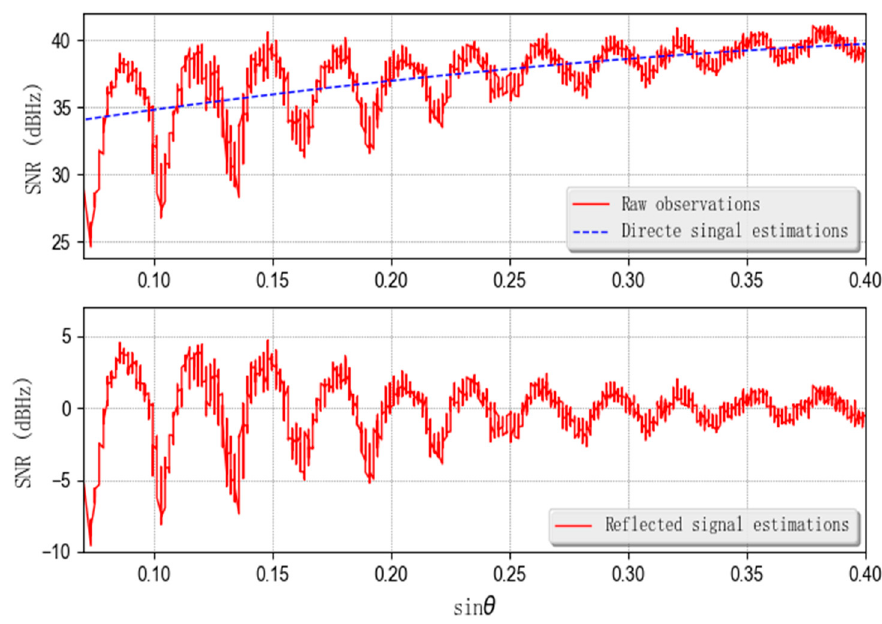
Figure 2. A measured SNR series from receiver and a reflected signal series.